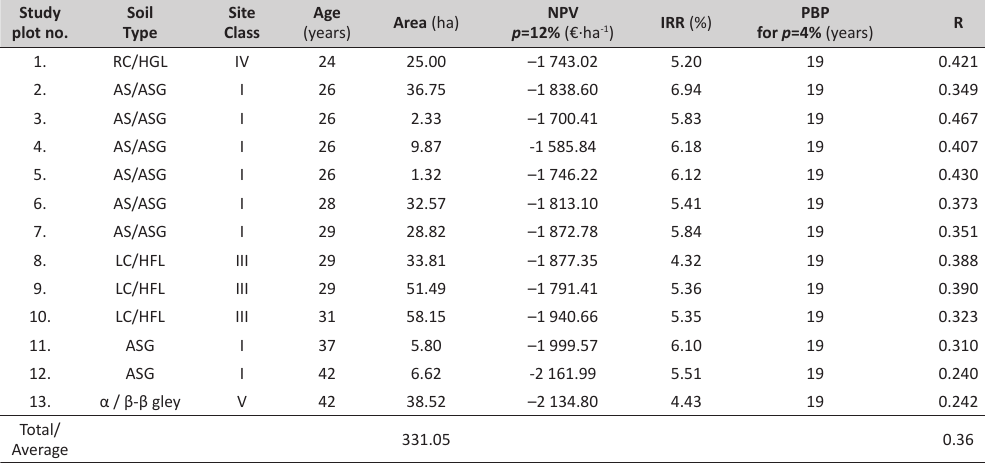
tABLe 1. Capital budgeting on poplar plantation on sample plots in Study plot no.